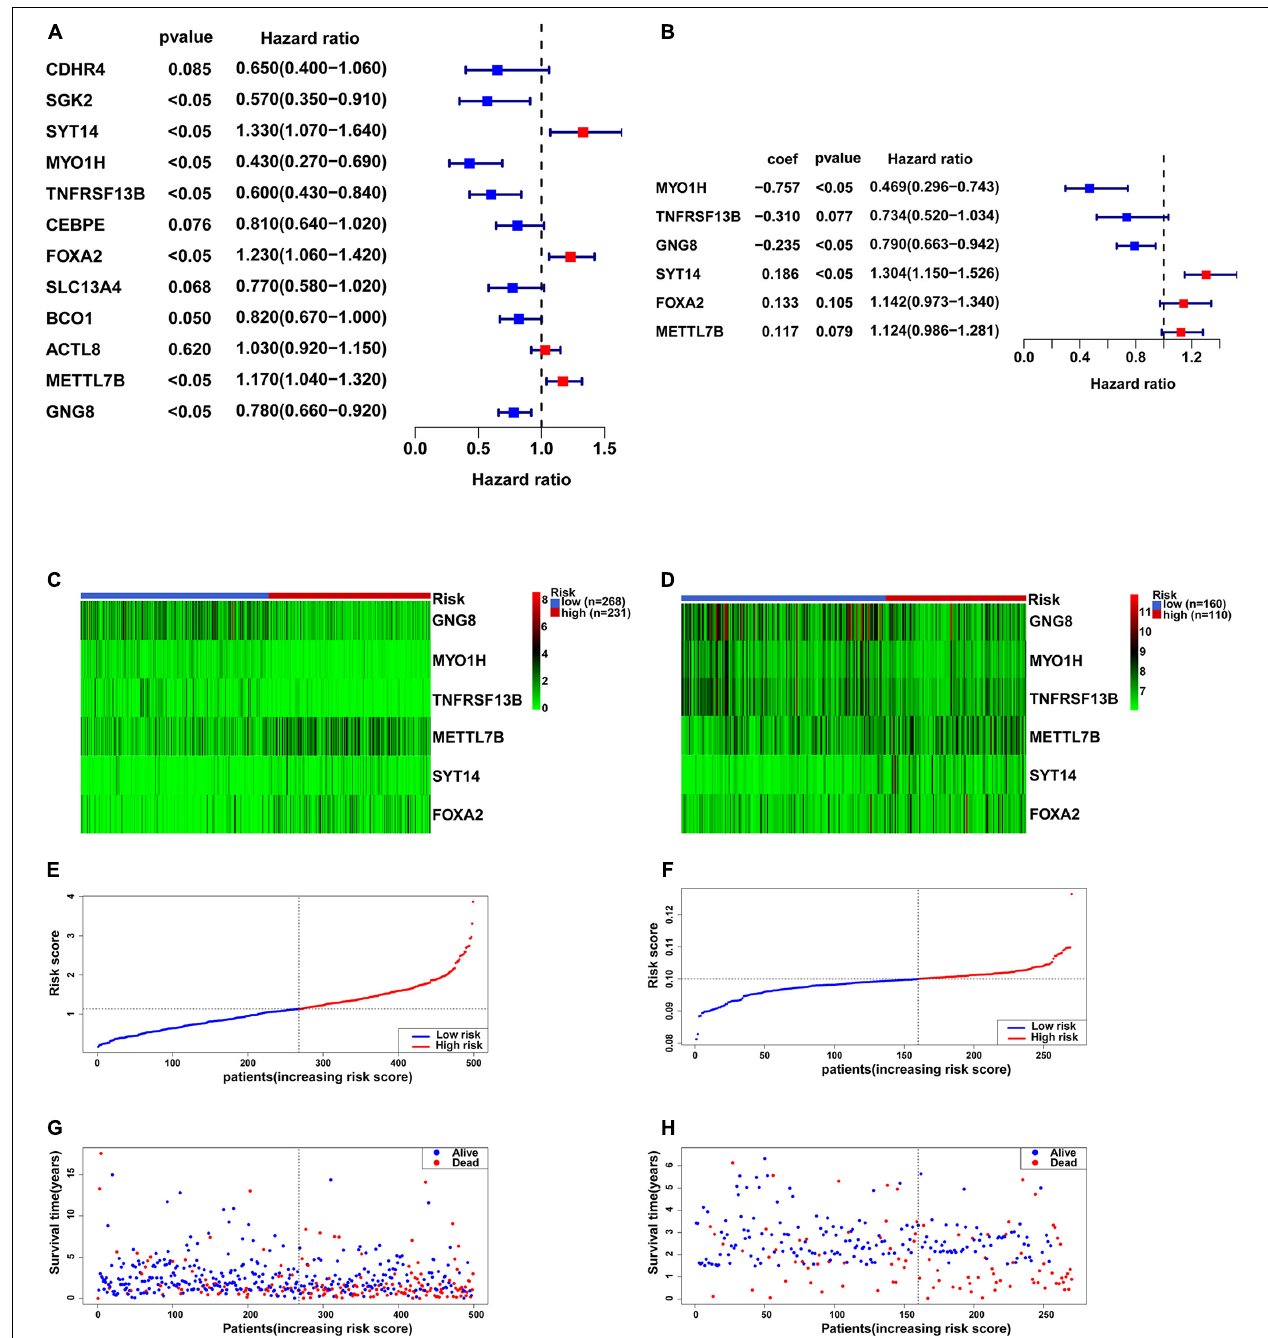
FIGURE 5 | Construction of the six-gene prognostic signature. (A) Univariate Cox proportional hazards regression analysis was used to assess whether genes have significant prognostic value. (B) Multivariate Cox proportional hazards regression analysis was used to construct a risk biological prognostic signature. coef is the regression coefficient. (C) Heatmap of the six genes in the signature in TCGA. (D) Heatmap of the six genes in the signature in GSE65858. (E) The risk score of each HNSCC patient in TCGA. (F) The risk score of each HNSCC patient in GSE65858. (G) The survival status and overall survival time of each HNSCC patient in TCGA. (H) The survival status and overall survival time of each HNSCC patient in